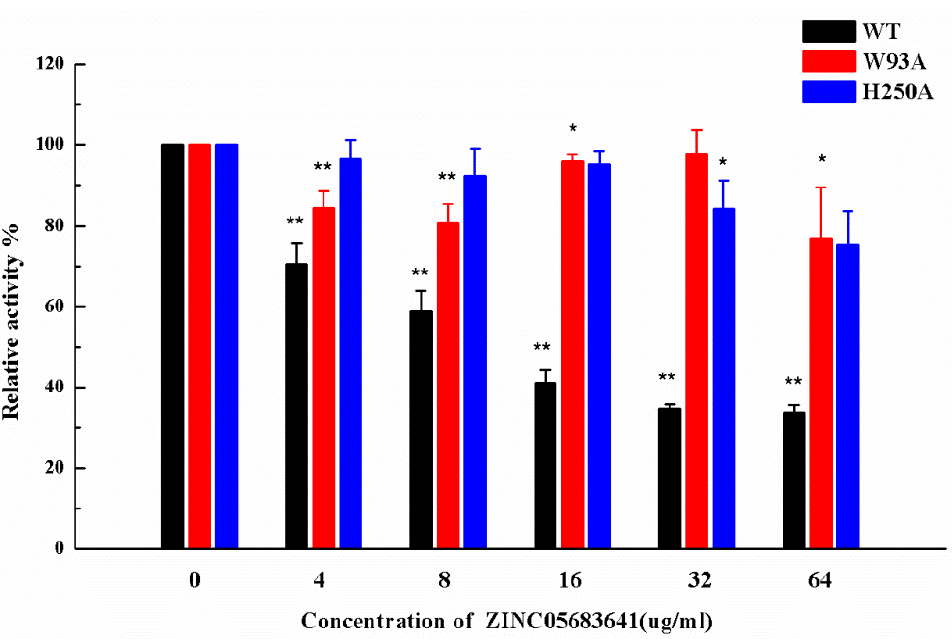
Figure 5. The inhibitory effect of ZINC05683641 on WT-NDM-1 and its mutants. The column diagrams show the hydrolysis activity of WT-NDM-1 (black), W93A (red), and H250A (blue). The hydrolysis activity of nitrocefin by WT-NDM-1 was reduced by addition to ZINC05683641 with the final concentrations of 4, 8, 16, 32 and 64 μ g/mL. However, the addition of ZINC05683641 to W93A and H250A did not lead to inhibitory effects. All data are shown as means ± SD of three independent experiments. * indicates p < 0.05 and ** indicates p < 0.01 compared with the drug-free group; two-tailed Student’s test.